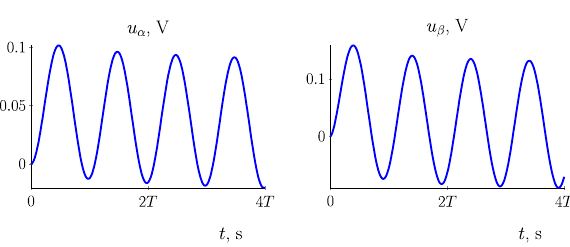
Fig. 2. Fractional capacitor voltage time functions obtained through the gcdAlpha